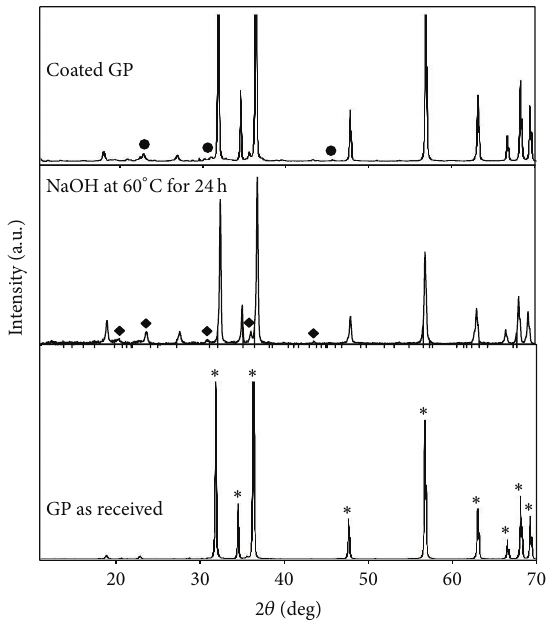
Figure 2: XRD analysis of GP, GP treated with NaOH, and Tas-SBF coated GP. ∗ ZnO (GP) X NaOH e HA /calcium phosphate.